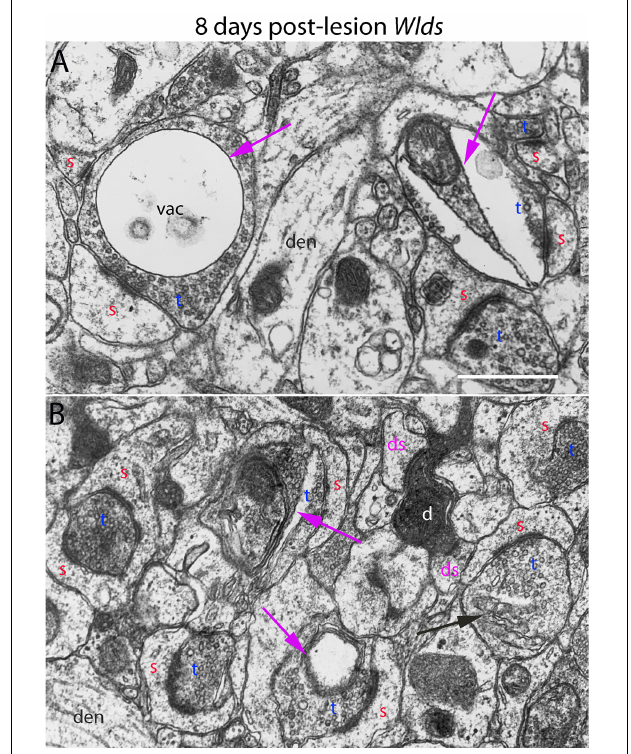
FIGURE 6 | Ultrastructural abnormalities of synapses at 8 days post-lesion in Wld s mice. (A) Terminals exhibiting abnormalities as vacuoles and membrane-delimited vacuoles surrounded by areas of essentially normal-looking presynaptic cytoplasm with vesicles. (B) A rare example of a terminal exhibiting dark-dense degeneration amongst other synapses on spine heads with chaliciform morphologies. Red s (red), spine head; t (blue), non-degenerating synaptic terminal; d (white) degenerating synaptic terminal; ds (purple) spine contacted by degenerating presynaptic terminal; den, dendrite; pr, polyribosomes. Calibration bar in (A) = 0.25 µ m and applies to (A,B) .